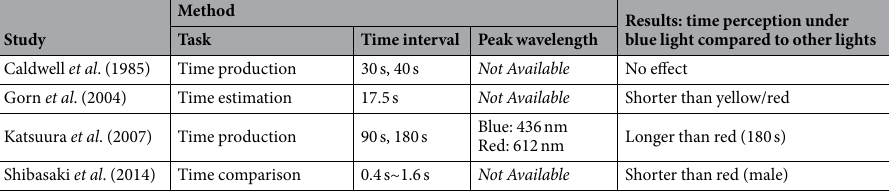
Table 1. Summaries of studies on blue light effect on time